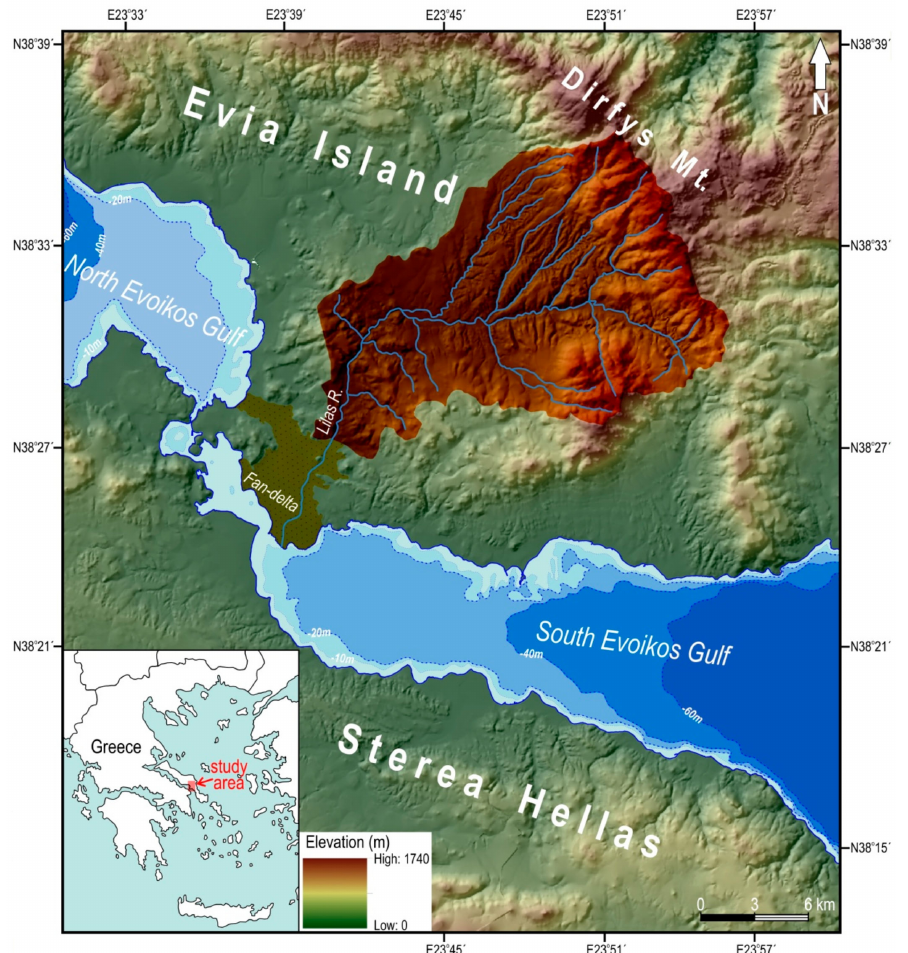
Figure 1. Digital elevation model (DEM) of the broader area of the Lilas River catchment and fan delta. The bathymetry of the northern part of the South Evoikos Gulf as well as the southern part of the North Evoikos Gulf are also